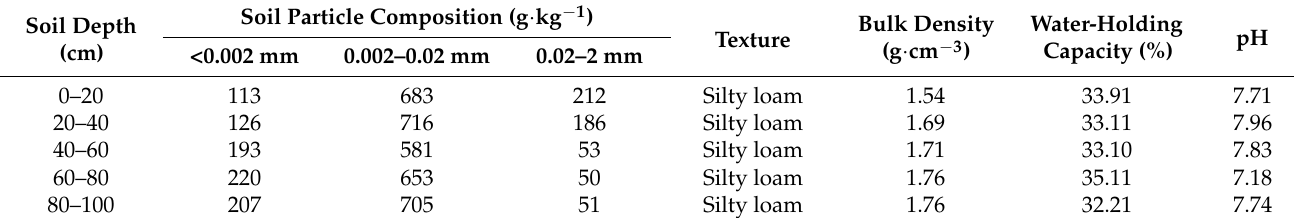
Figure 2. Daily meteorological variation during cotton growth periods (1 April to 30 October) in 2018 and 2019. Table 1. Physical and chemical properties of soil at the test site.